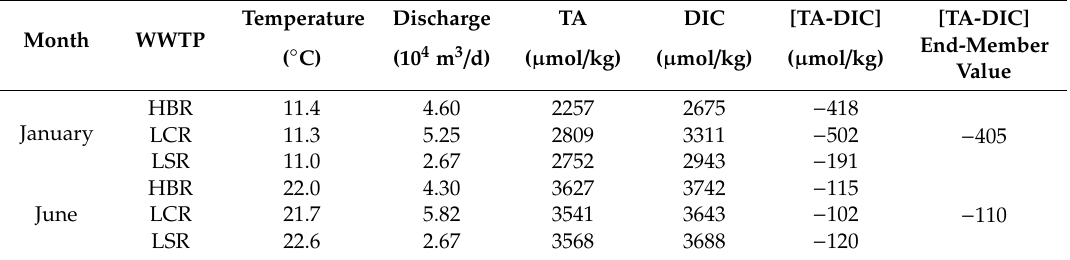
Table 1. Discharge of three WWTPs in January and June, and their corresponding temperature, TA, DIC and [TA-DIC] [44]. HBR, LCR and LSR were Haibo River, Licun River and Loushan River, respectively. The end-member values of [TA-DIC] were calculated by [TA-DIC] values of three WWTPs according to the proportion of